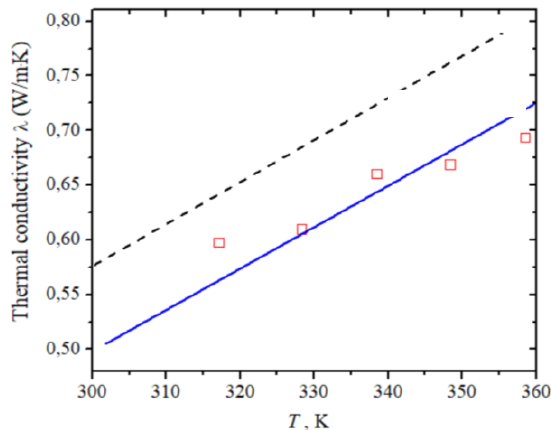
Figure 13. Temperature dependences of epoxy-based composite doped with 10% (volume) few layer graphene flakes [102]. - - - calculation without graphene size effect; —— calculation with graphene graphene flakes [102]. - - - calculation without graphene size effect; ─── calculation with graphene size effect; experimental points—[106]. size effect; experimental points—[106].